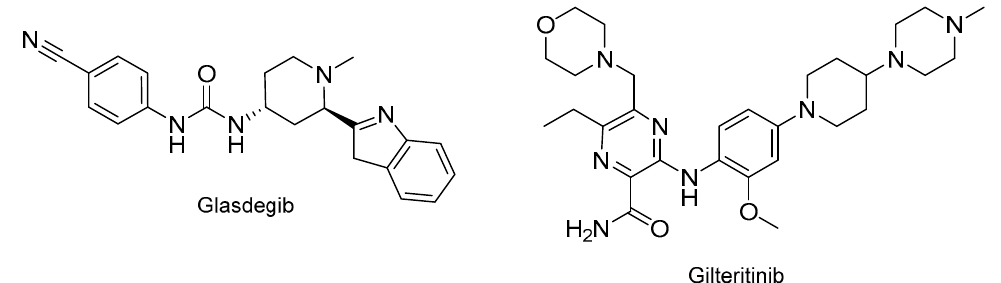
Figure 18. Structure of thiazol-2-amide (in red) containing molecules.